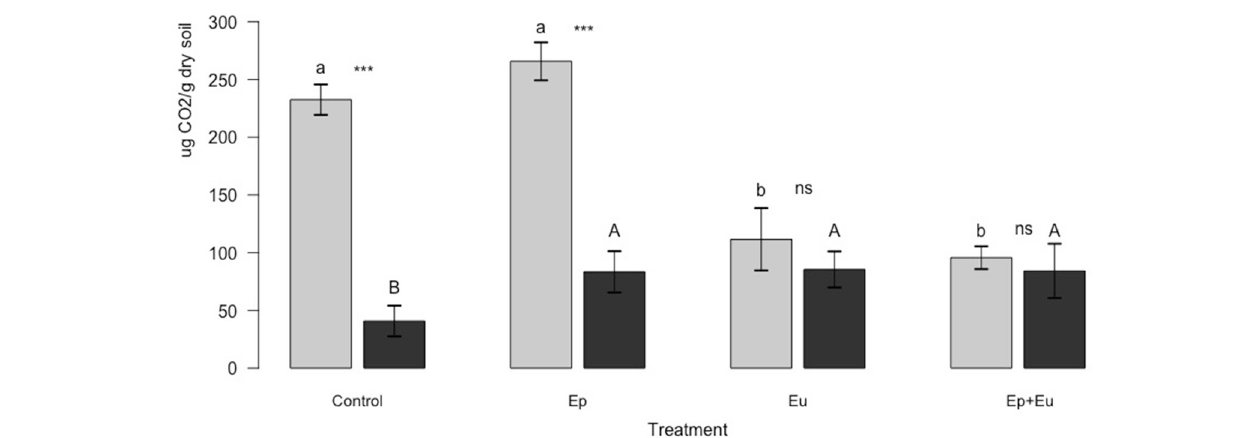
FIGURE 2 | CO 2 release (mean ± standard deviation) of four experimental treatments 1 and 2 months after Collembola re-inoculation. Gray bar-plot = first month, black bar-plot = second month. Different minuscule letters (i.e., “a,” “b”) indicate significant differences ( α = 0.05) between treatments for first month; Different capital letters (i.e., “A,” “B”) indicate significant differences ( α = 0.05) between treatments for second month. The asterisks indicate significant differences between the months for a given treatment (*** p < 0.001, ns p > 0.05). Control, without Collembola; Ep, Epedaphic Collembola; Eu, Euedaphic Collembola; Ep + Eu, mixed functional groups ( n = 4).